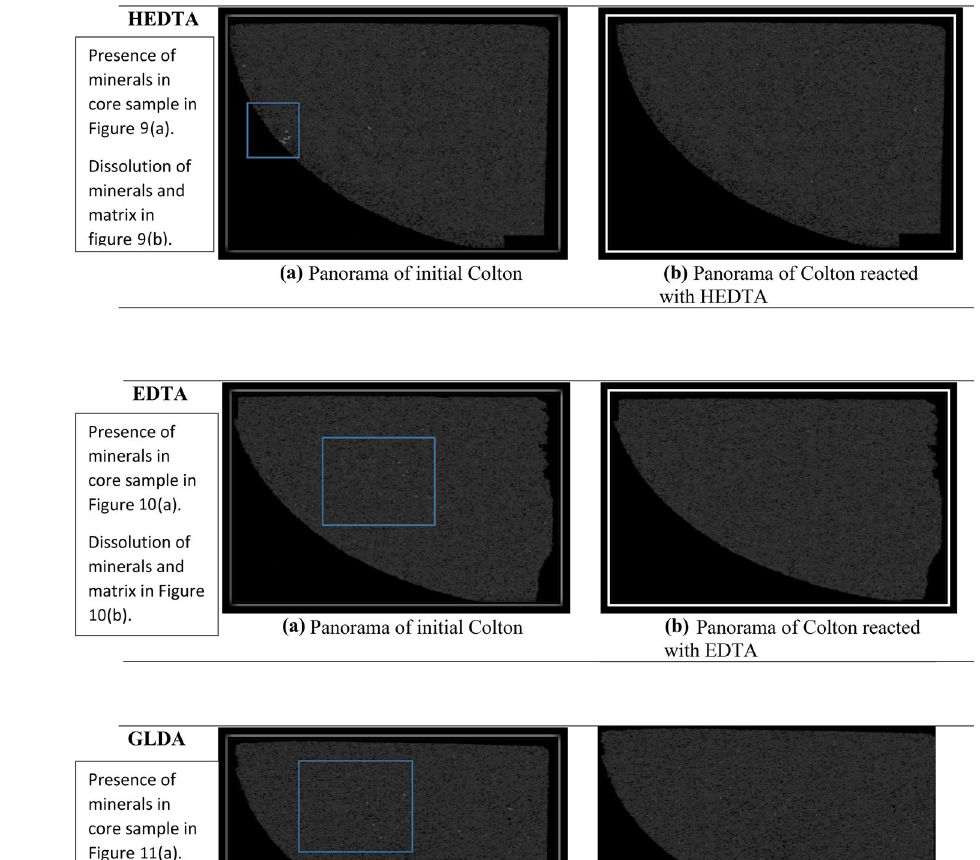
Fig. 11 a Panorama of initial Colton. b Panorama of Colton reacted with GLDA